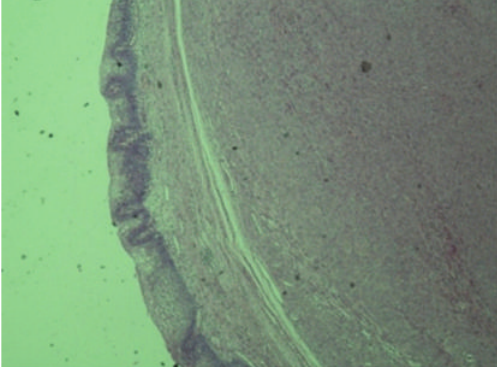
Figure 2: Histopathology 40x-bladder mucosa with submucosal encapsulated